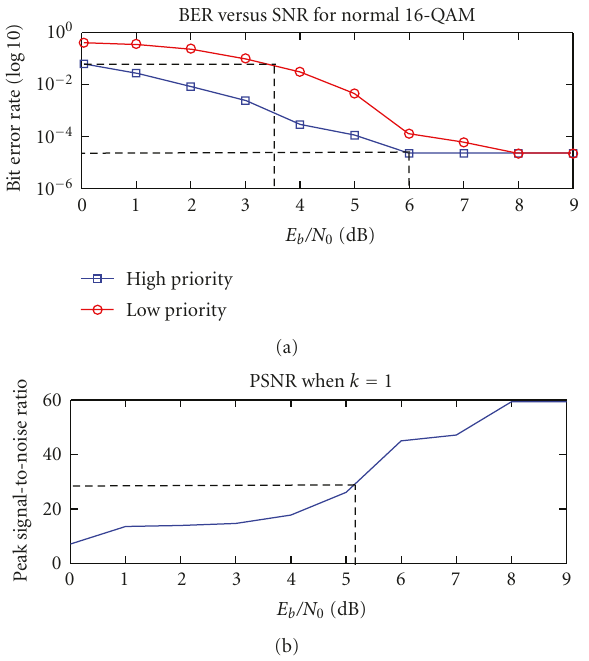
Figure 12: BER and PSNR curve for Hierarchical Modulation of k = 1.